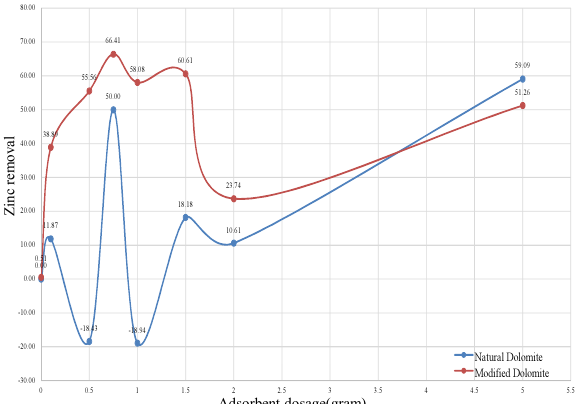
Fig. 8. Comparison of removal rate of lead from natural dolomite (5 mg/l) and modified dolomite with contact time of 15 minutes in specified adsorbents